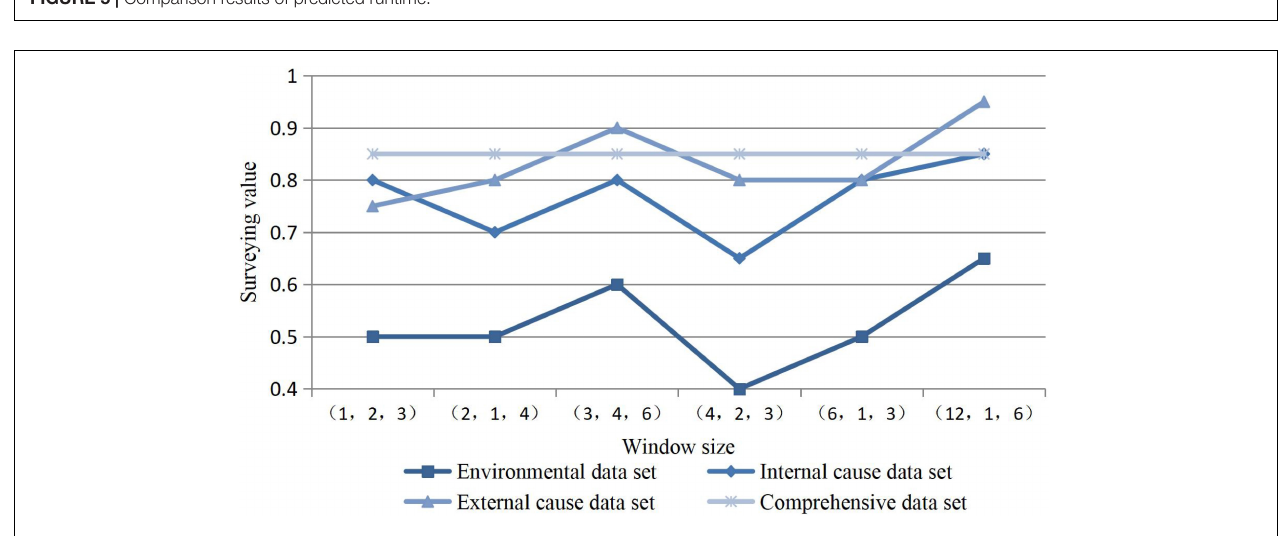
FIGURE 6 | Prediction results of the window size data